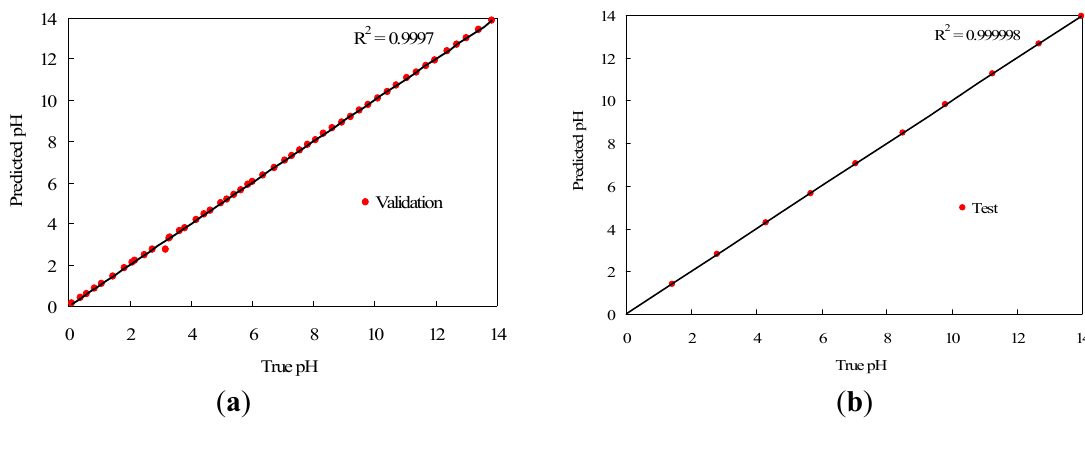
Figure 5. ( a ) Validation and ( b ) test measurements.